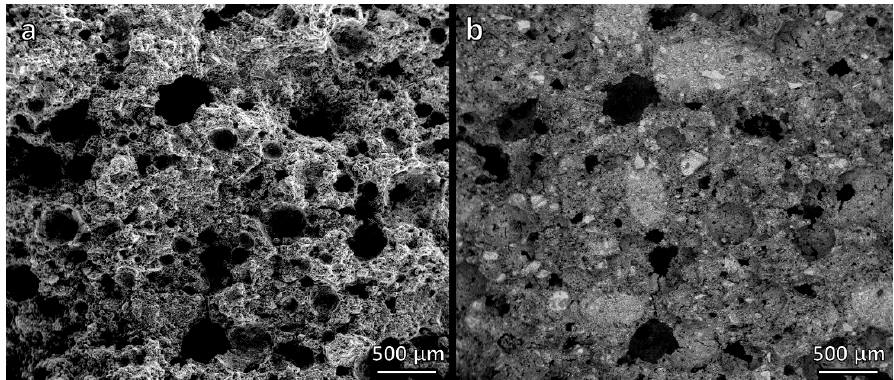
Figure 8. Red mud/glass-derived porous glass-ceramic: ( a ) morphology; ( b ) compositional Figure 8. Red mud / glass-derived porous glass-ceramic: ( a ) morphology; ( b ) compositional gradients.